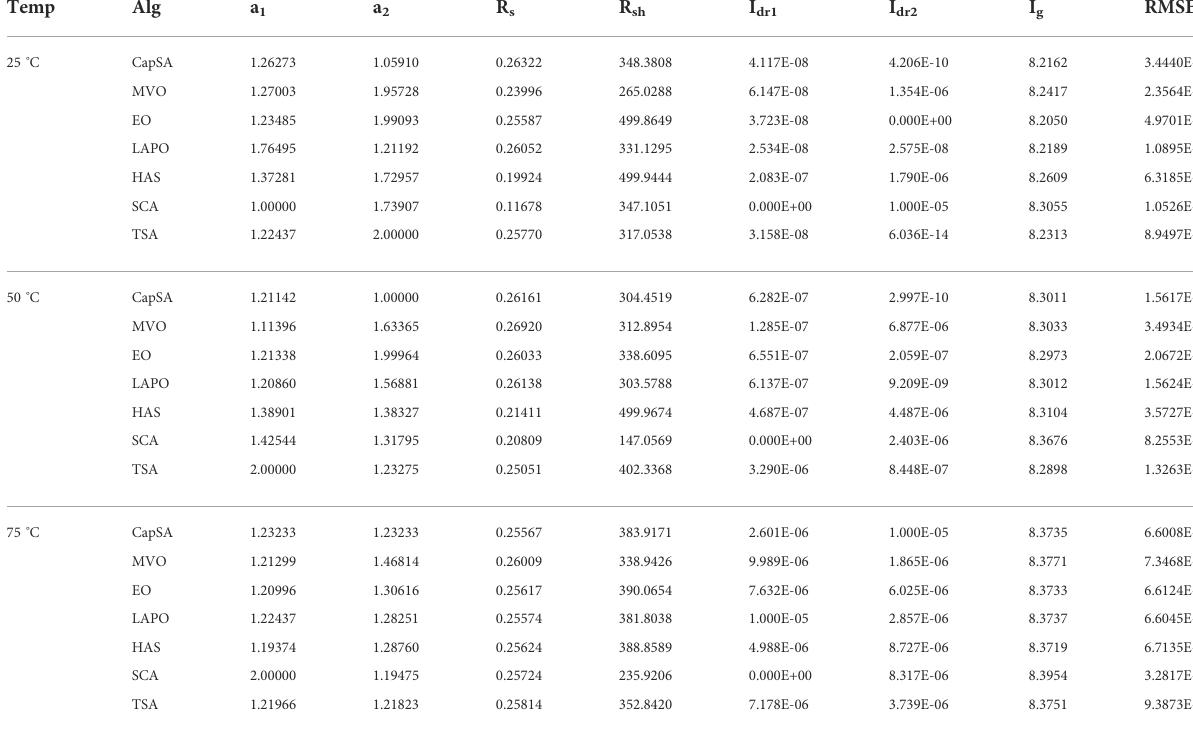
TABLE 10 Optimal parameters of DDM for the KC200GT PV panel at different temperatures.